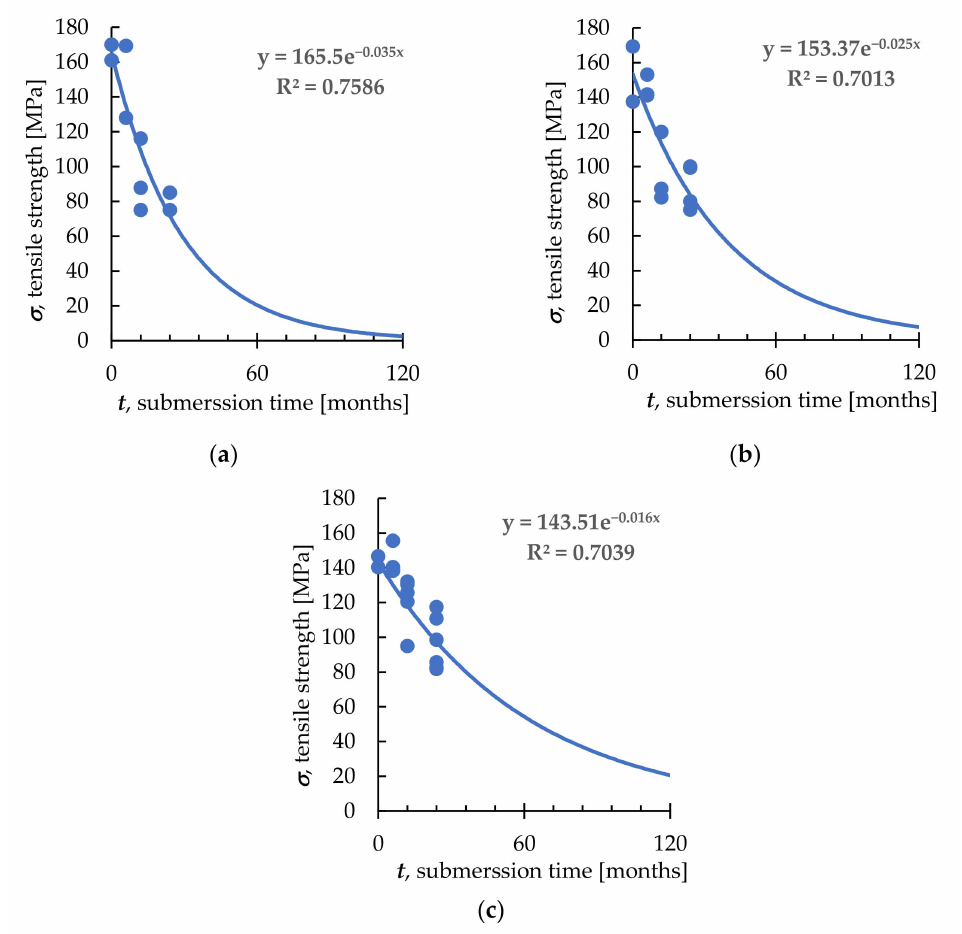
Figure 3. Mathematical strength degradation prediction model: ( a ) UD0 ◦ ; ( b ) (0/90) s; ( c ) (0/45/90) s fiber layout configuration.